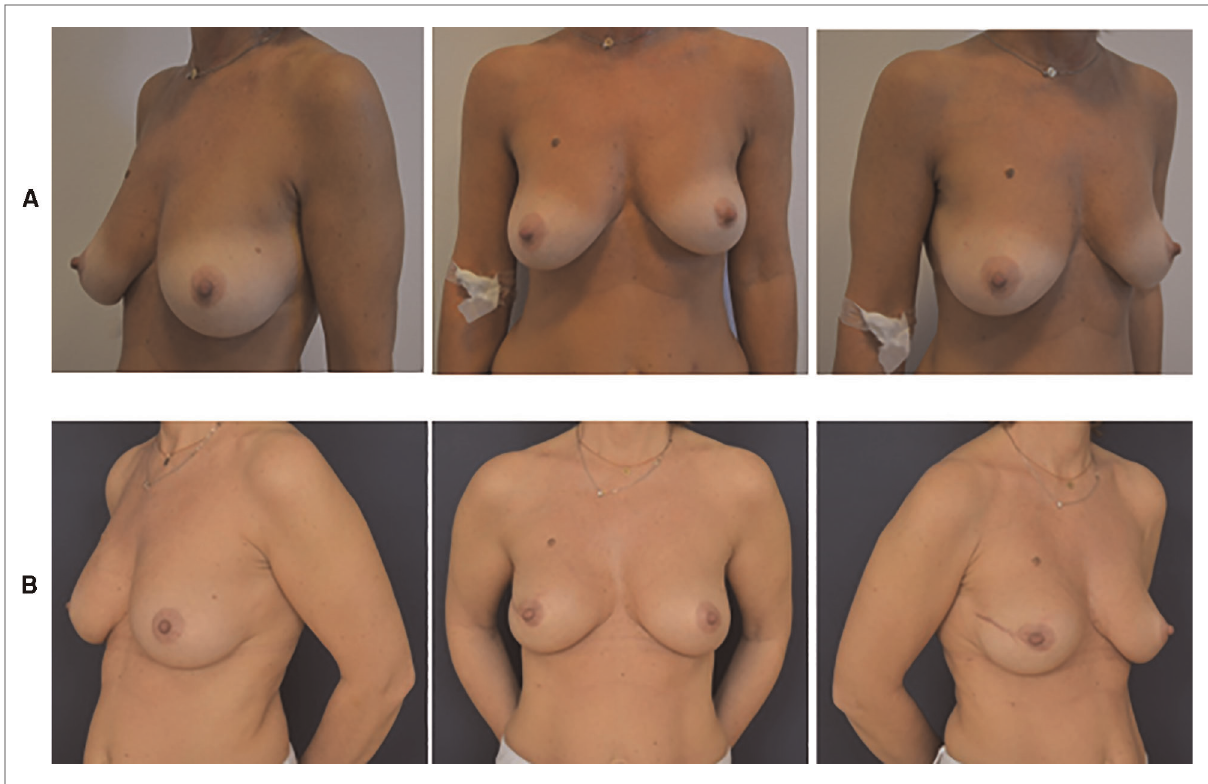
FIGURE 3 Pre- and postoperative pictures of BRAXON ® Fast -assisted PPBRs. ( A ) Patient with right breast cancer: preoperative pictures. ( B ) Patient with left breast cancer: 10 months after right prepectoral reconstruction surgery with BRAXON ® Fast and breast